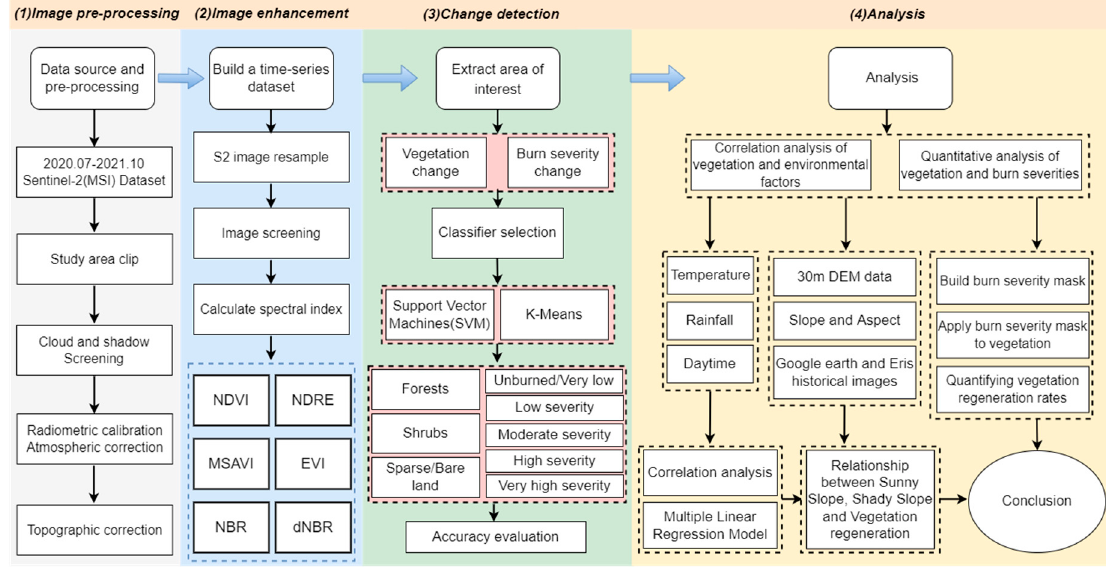
Figure 3. Flow chart of spatiotemporal monitoring and analysis of post-fire vegetation regeneration.